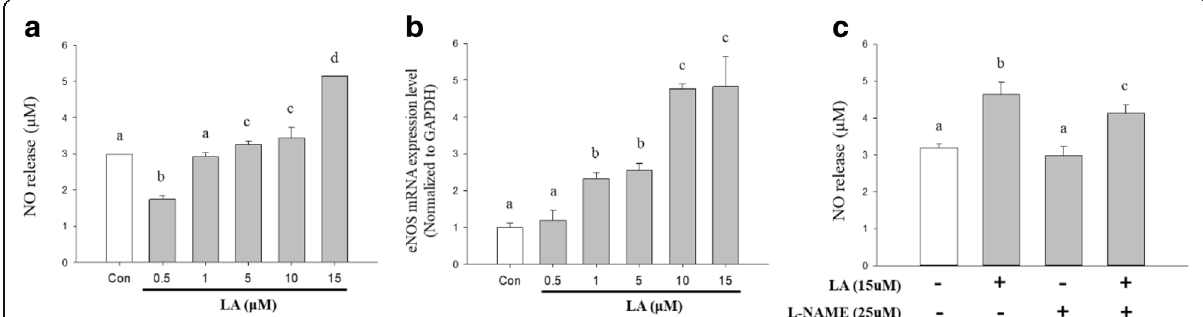
Fig. 2 The effects of LA on nitric oxide synthesis in HUVECs. a HUVECs were treated with various concentrations of LA (0.5, 1, 5, 10, and 15 μ M) for 24 h, followed by the Griess assay. Con - non-treated negative control ( b ) The expression of eNOS mRNA levels in HUVECs, the cells were treated with various concentrations of LA (0.5, 1, 5, 10, and 15 μ M) for 24 h, followed by the measurement of eNOS mRNA expression levels using qRT-PCR. These data are normalized by the mRNA expression levels of GAPDH. c Measurement of the activity of LA against the L-N( g )-nitro-L- arginine methyl ester (L-NAME)-induced decrease of nitric oxide (NO) production. The cells were treated with 15 μ M LA for 24 h, after which they were treated with 25 μ M L-NAME for 24 h, followed by the Griess assay. Different letters indicate a statistically significant difference between each group at * P < 0.05, as determined by Duncan ’ s multiple-range test